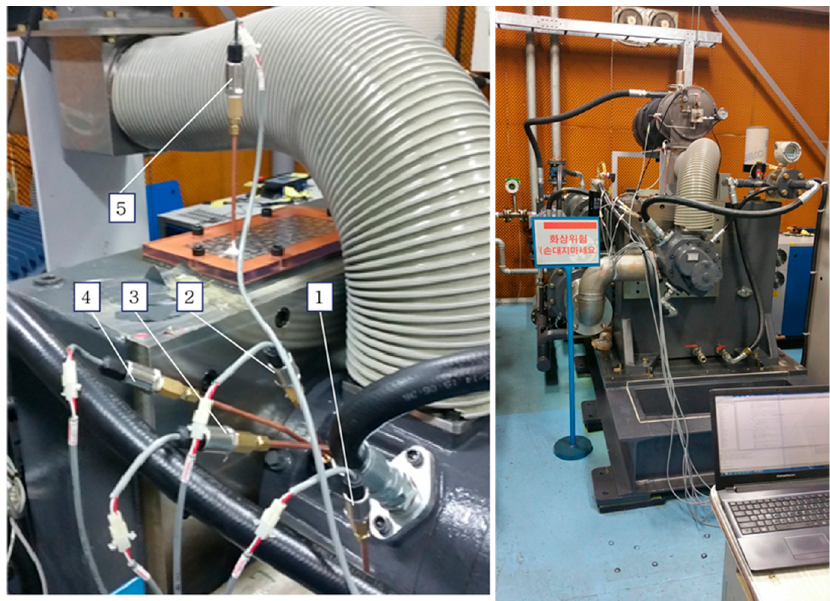
Figure 9. Experimental setup of the test bench [18].